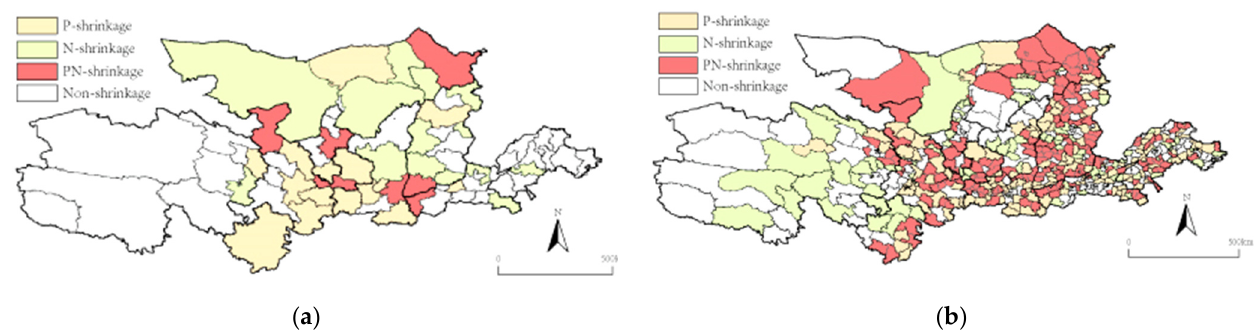
Figure 5. Spatial distribution map showing bivariate shrinkage recognition: ( a ) shrinkage patterns at the city scale; ( b ) shrinkage patterns at the district scale.